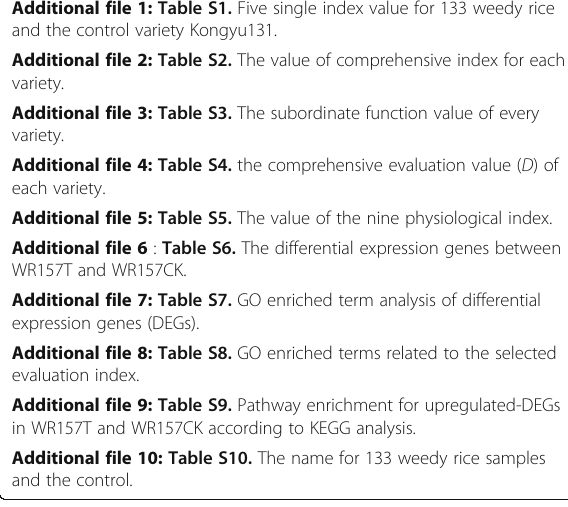
Additional file 7: Table S7. GO enriched term analysis of differential expression genes (DEGs). Additional file 8: Table S8. GO enriched terms related to the selected evaluation index.